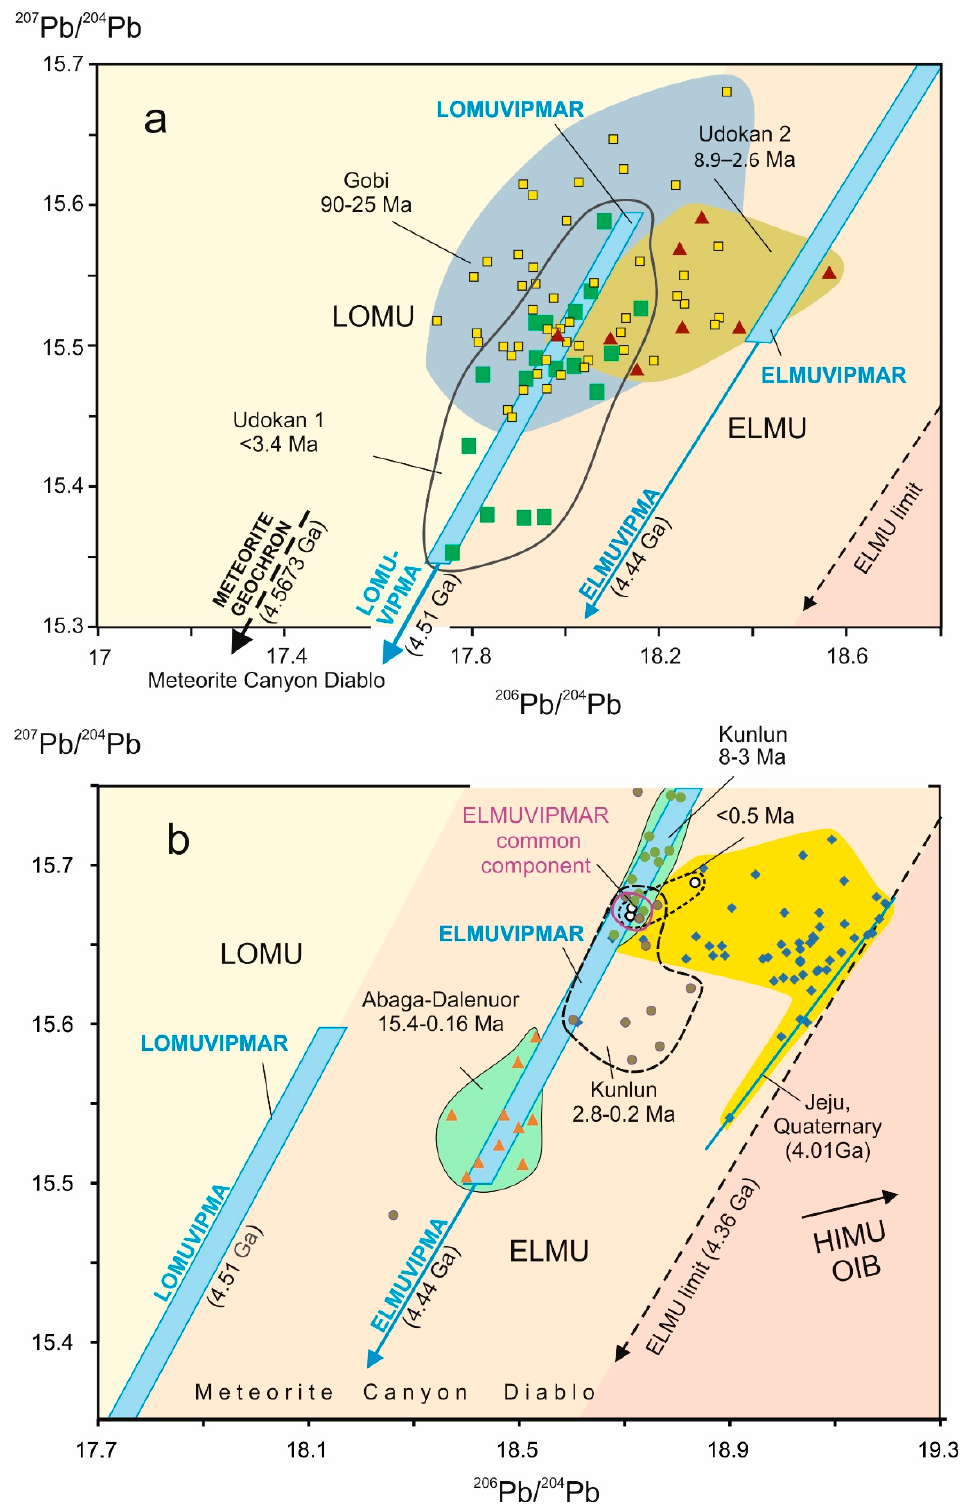
Figure 5. Diagrams of 207 Pb/ 204 Pb versus 206 Pb/ 204 Pb for identifying Low µ Viscous Protomantle Reservoir (LOMUVIPMAR) ( a ) and Elevated µ Viscous Protomantle Reservoir (ELMUVIPMAR) ( b ). Here and below, a time interval of volcanic eruptions is shown in Ma and a calculated source age of the viscous mantle is designated in Ga with brackets. In diagram ( a ), the LOMUVIPMAR composition is defined by a data set obtained for volcanic rocks from the northwest of the Udokan volcanic field.